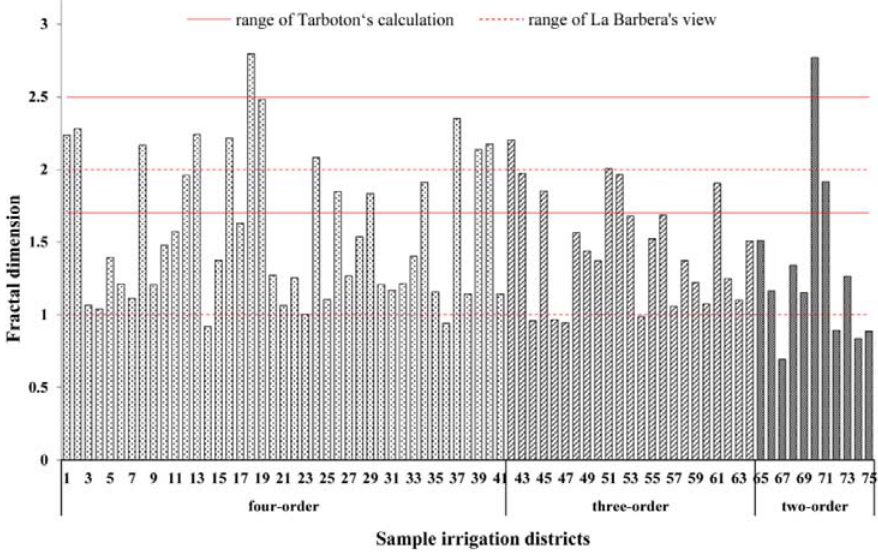
Figure 3. Fractal dimension of the canal system in the sample irrigation areas.